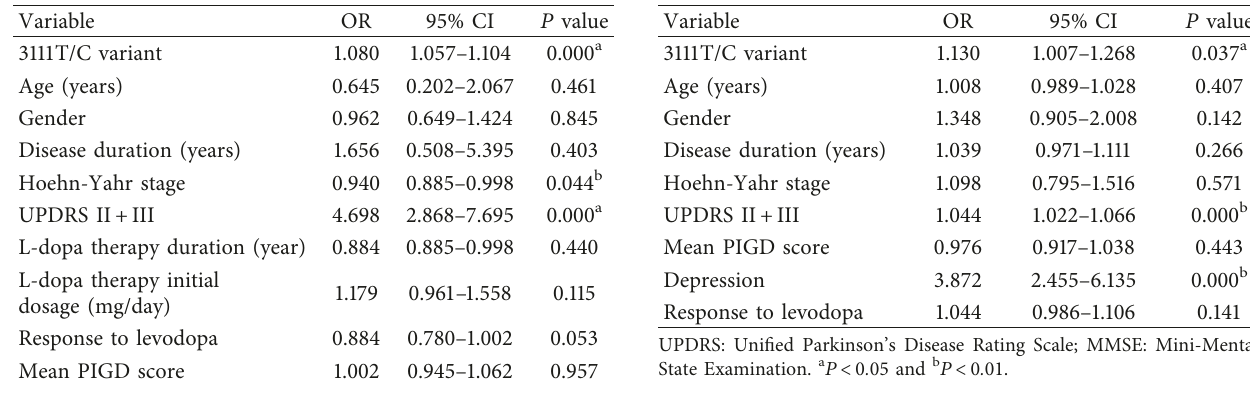
Table 2: Binary logistic regression of association between motor fluctuation and CLOCK 3111T/C variant.